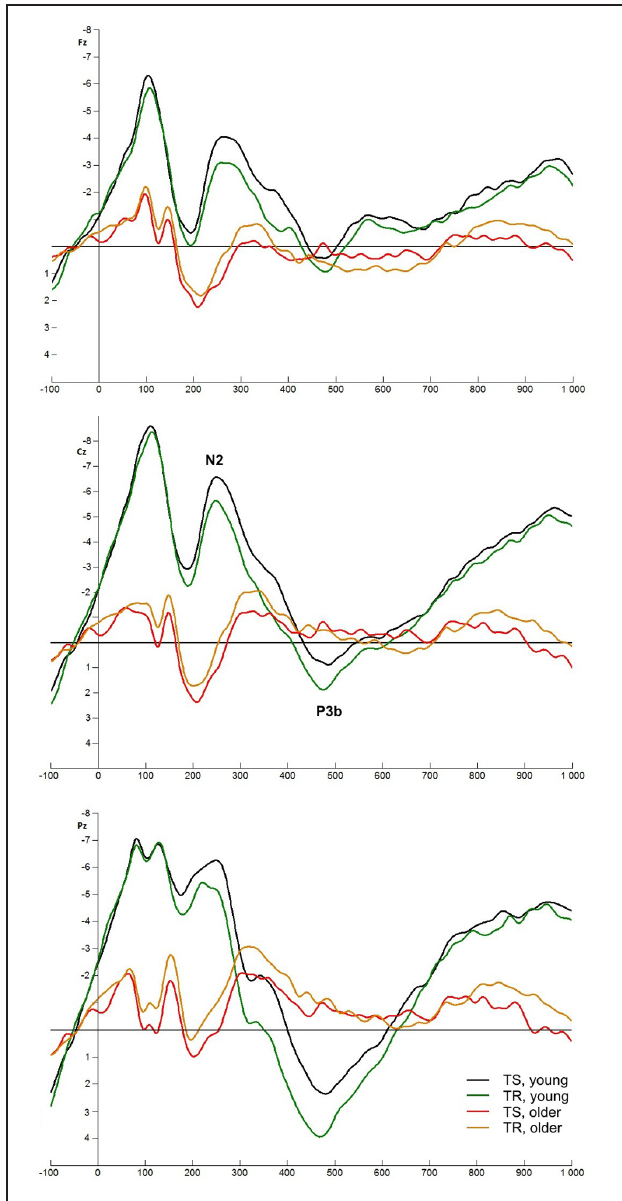
FIGURE 6 | Target-locked ERPs at Fz, Cz, and Pz electrodes. TS (young – black, older – red) and TR (young – green, older – orange) for color and shape classification